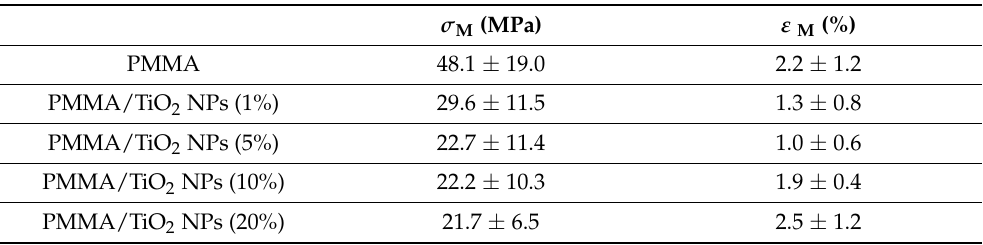
Table 1. The mean values with standard deviations of the maximum tensile stress ( σ M ) and the corresponding strain ( ε M ) of PMMA